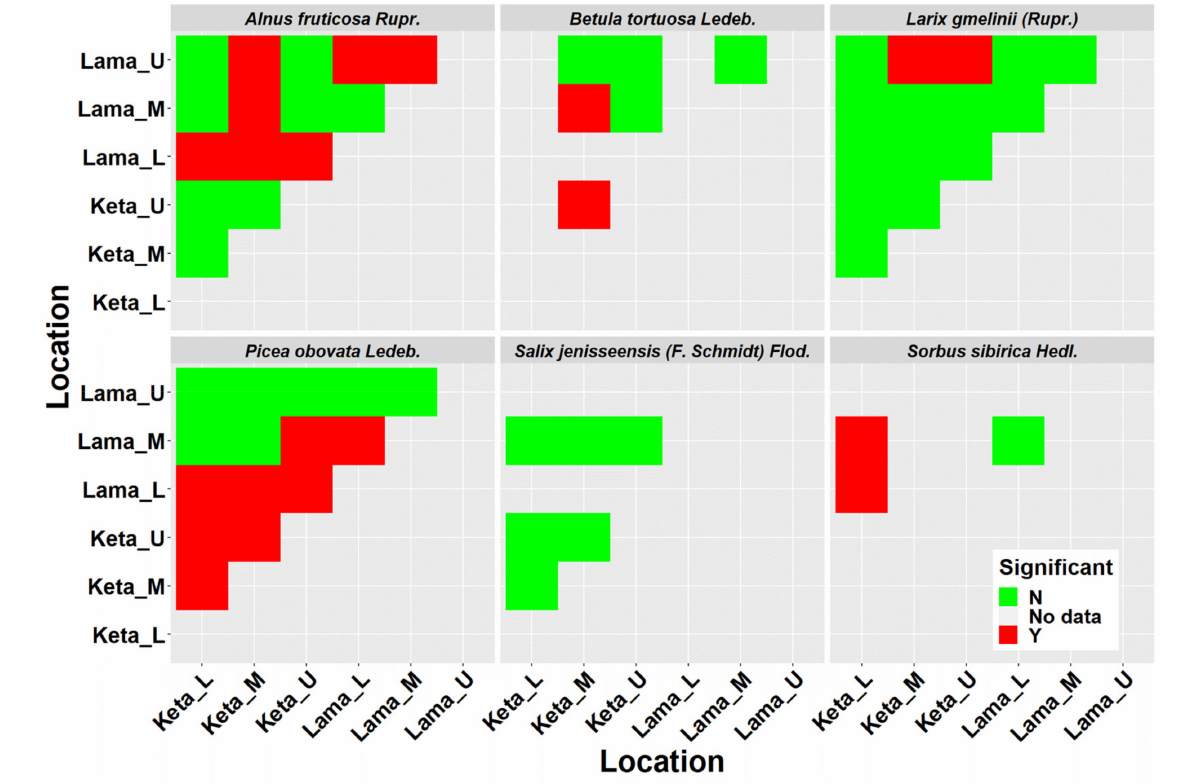
Figure A4. ANOVA-based statistical comparison of derived crown radius-height models (Table 2). N means not significant, Y means significant at 95% significance level. L, M, U represent lower, middle, and upper elevational zones,